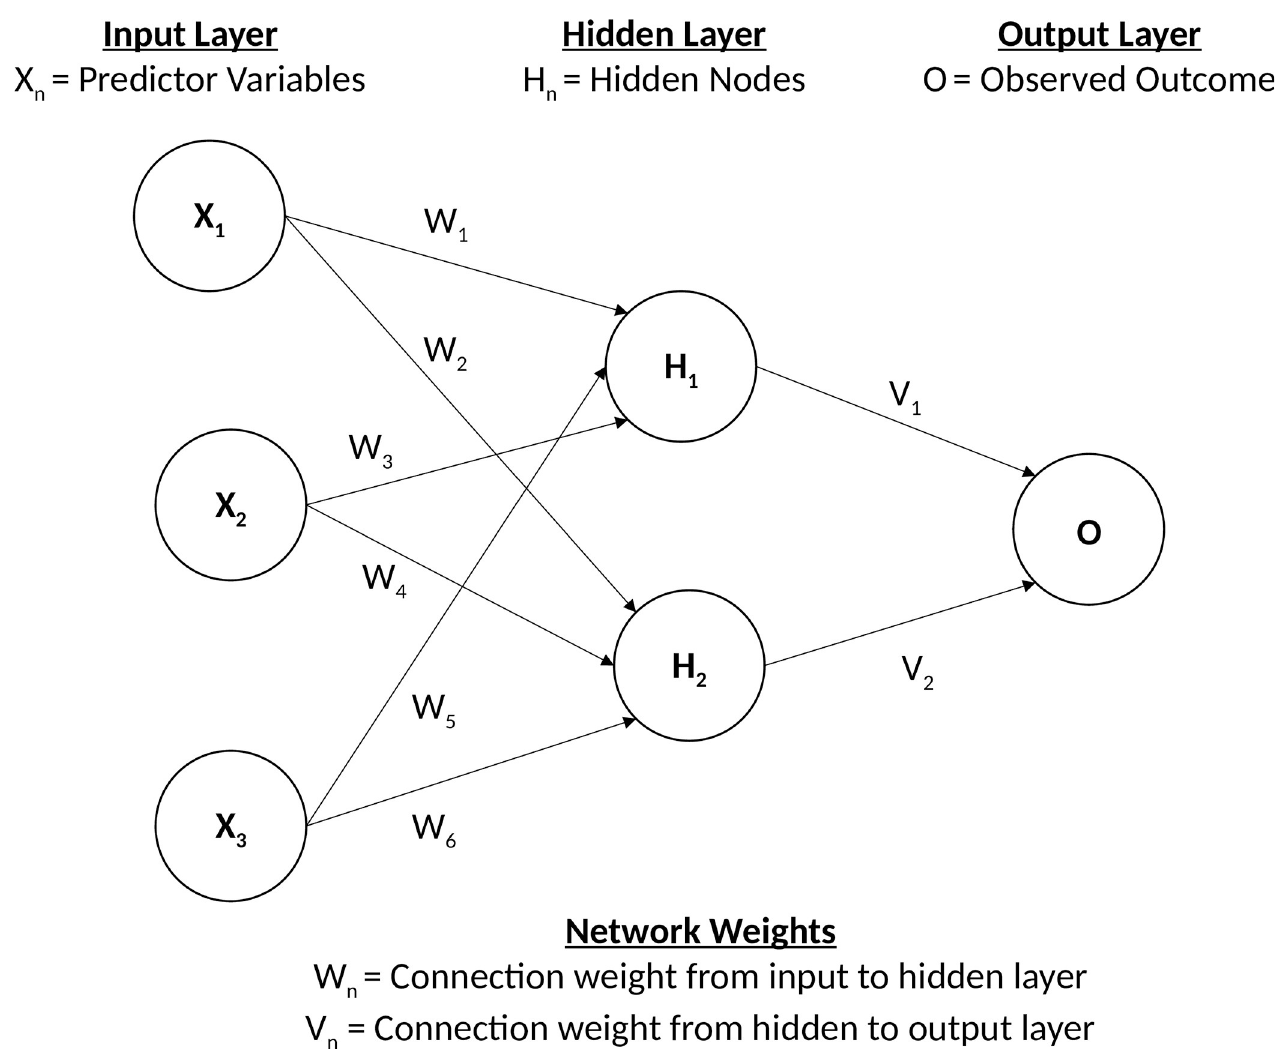
Fig 1. Example of a single hidden layer feed forward neural